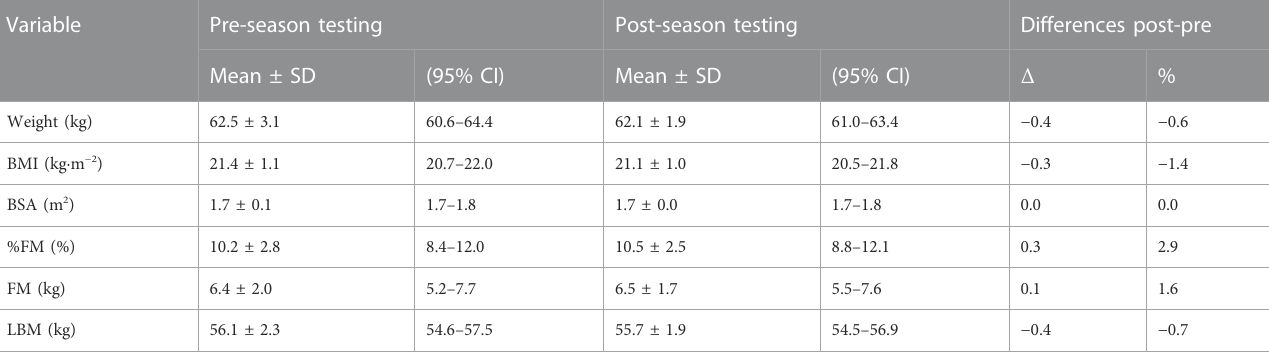
TABLE 2 Pre- and post-season testing mean ± standard deviation and 95% CI of anthropometrics variables. Variable